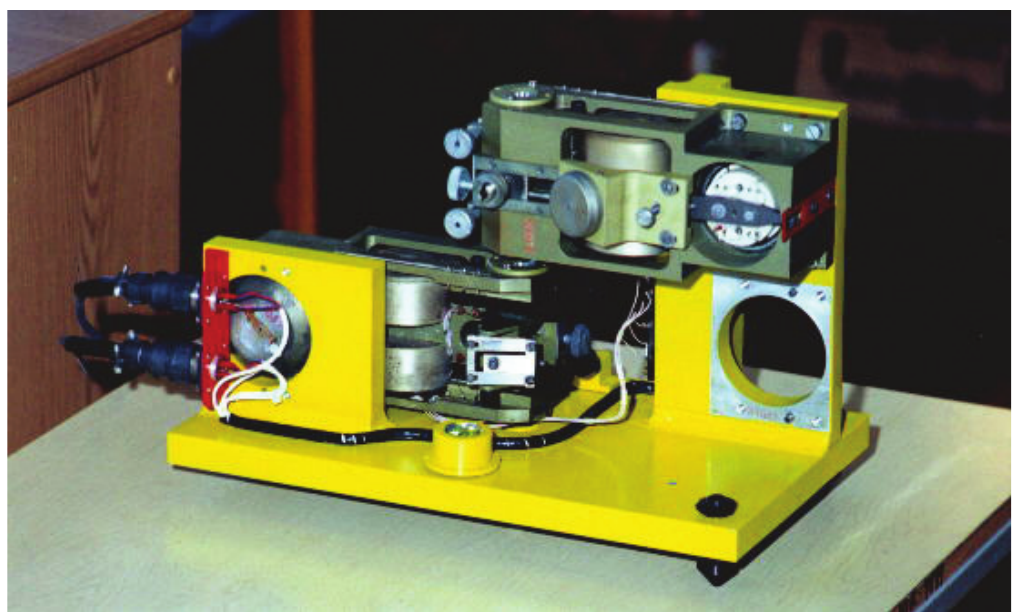
Fig. 2b. Rotation seismograph: photo.